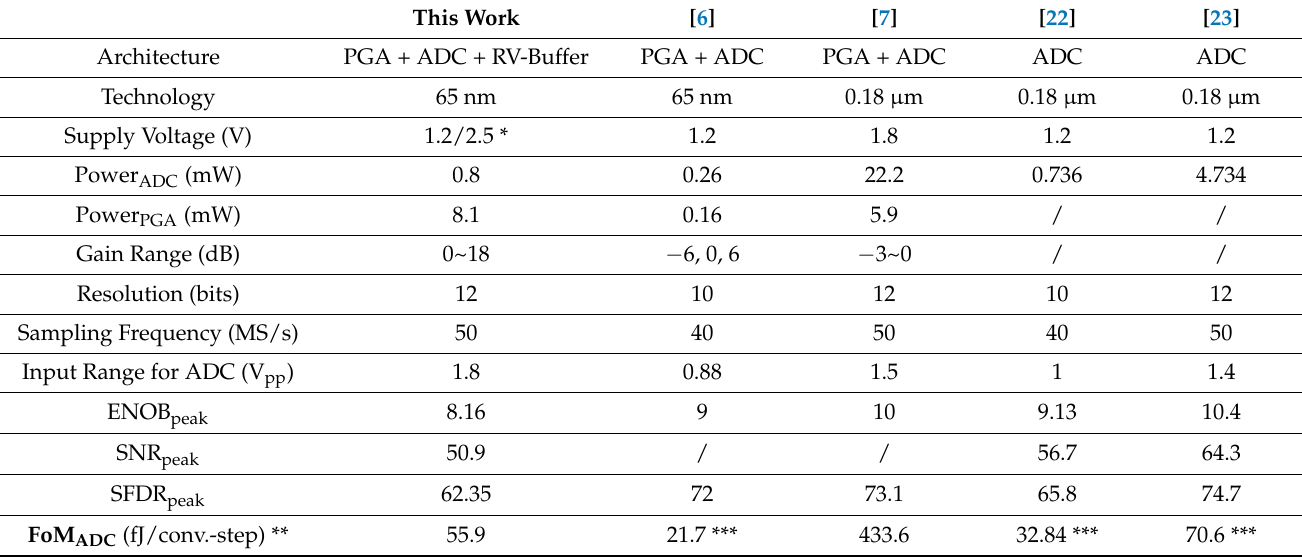
Table 2. Performance summary and